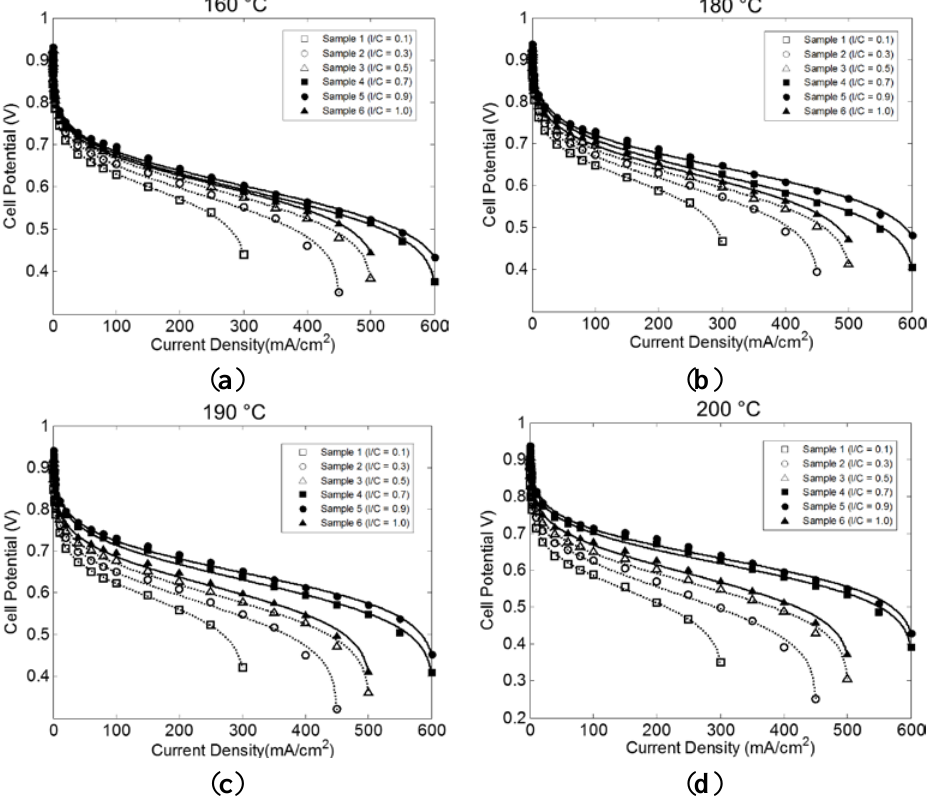
Figure 1. Correlation between experimental data and the coated film model developed in this work (curves are modeling results and points are experimental data from [28], reproduced with permission, with I/C ratios indicated in the figure legends). Cell operating